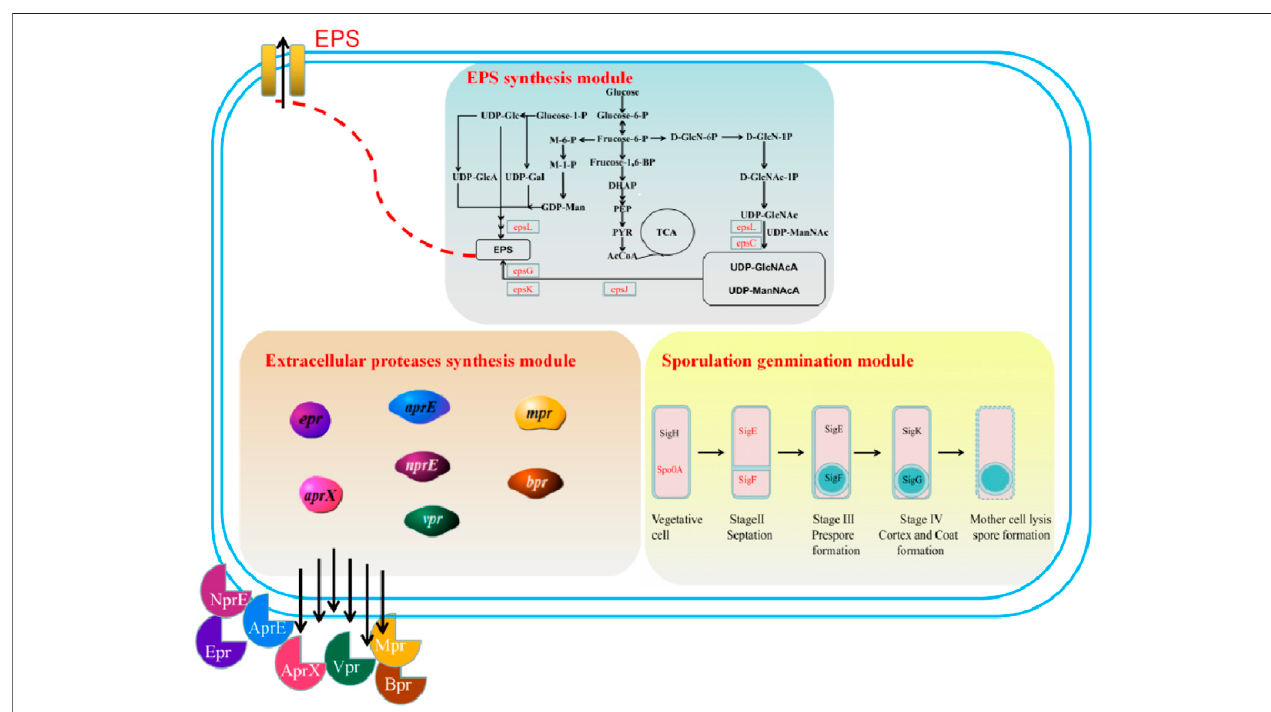
FIGURE 1 | A schematic of the proposed modules for the genetic engineering of B. amyloliquefaciens TCCC11018: Module I: sporulation germination module (vegetative cell, stage septation, stage prespore formation, stage cortex and coat formation, and mother cell lysis spore formatiom); Module II: extracellular protease synthesis module (neutral proteases (NprE), serine proteases (Epr, Bpr, Vpr, and AprX), an alkaline protease (AprE), and a metalloprotease (Mpr)); Module III: EPS biosynthesis module (including TCA cycle pathway, UDP-GlcNAcA/UDP-ManNAcA metabolism pathway, and UDP-Galactose metabolism